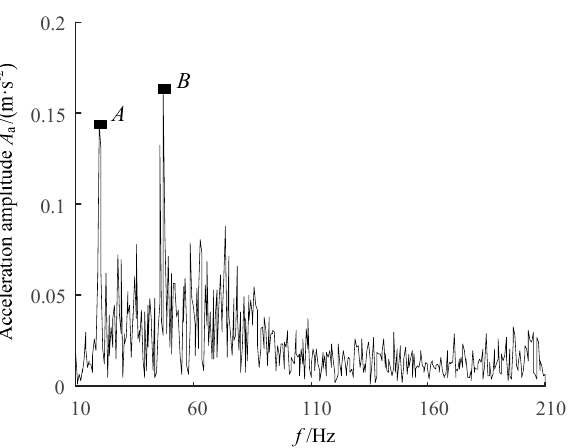
Figure 17. Amplitude-frequency characteristic curve of the fire-fighting jet system with the adaptive gun head.